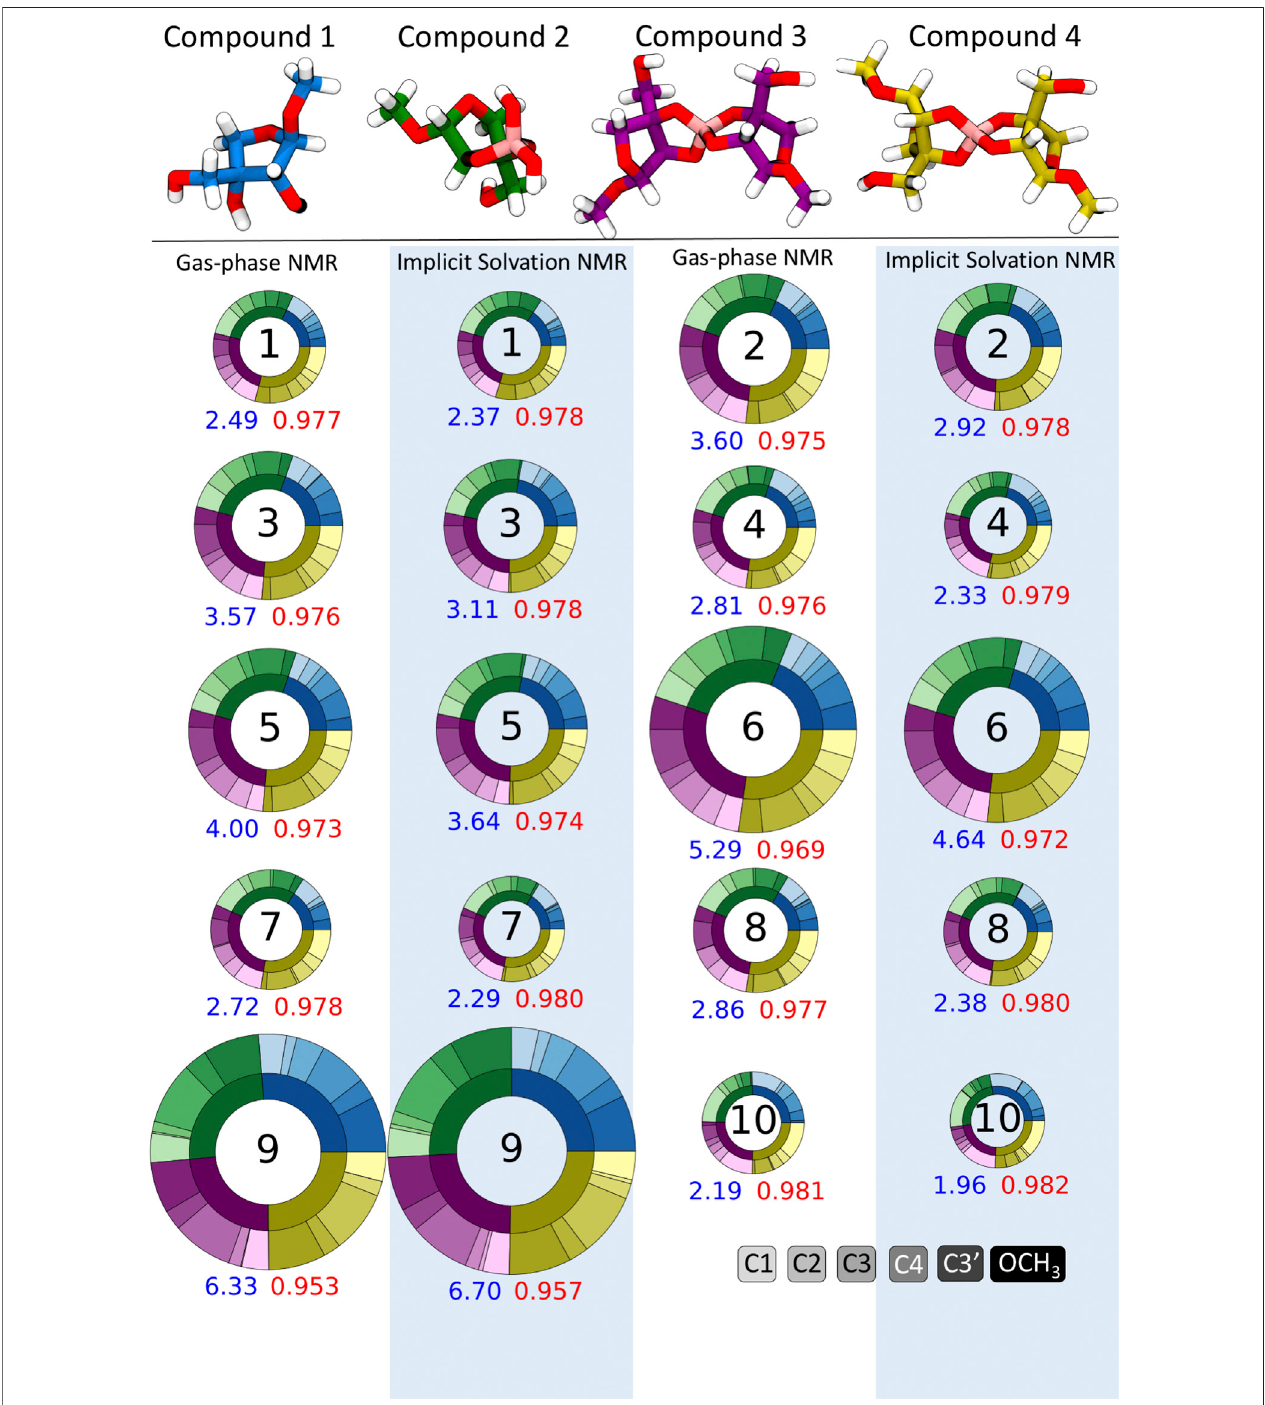
FIGURE 4 | Mean absolute errors (MAEs) in parts per million for 13 C nuclear magnetic resonance (NMR) predictions for NMR functional – basis sets (FBS) 1 – 10 represented as donut plots for gas-phase geometry optimizations. The donut size re fl ects the averaged MAE for each NMR FBS. The four colors within each donut indicate errors for each compound, and the shades within each color indicate errors on a speci fi c carbon atom. MAEs and r 2 values are shown in blue and red, respectively. Donuts on white and blue backgrounds indicate NMR values calculated in the gas phase and with implicit solvation, respectively.